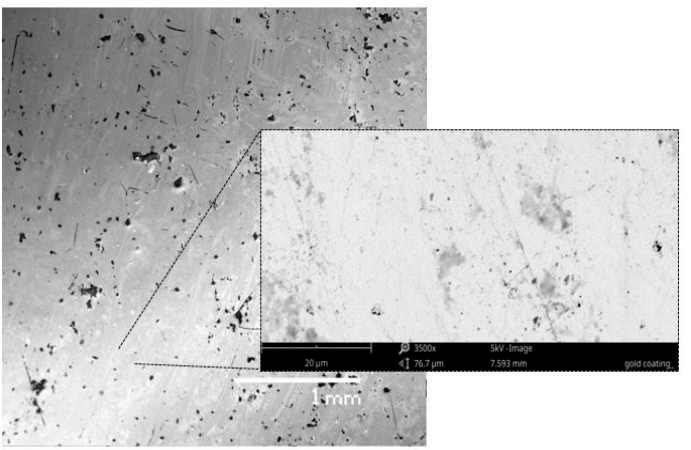
Figure 3. SEM image of the sputtered sensor. The zoomed view shows the quality of the sputtering on the sensing surface.